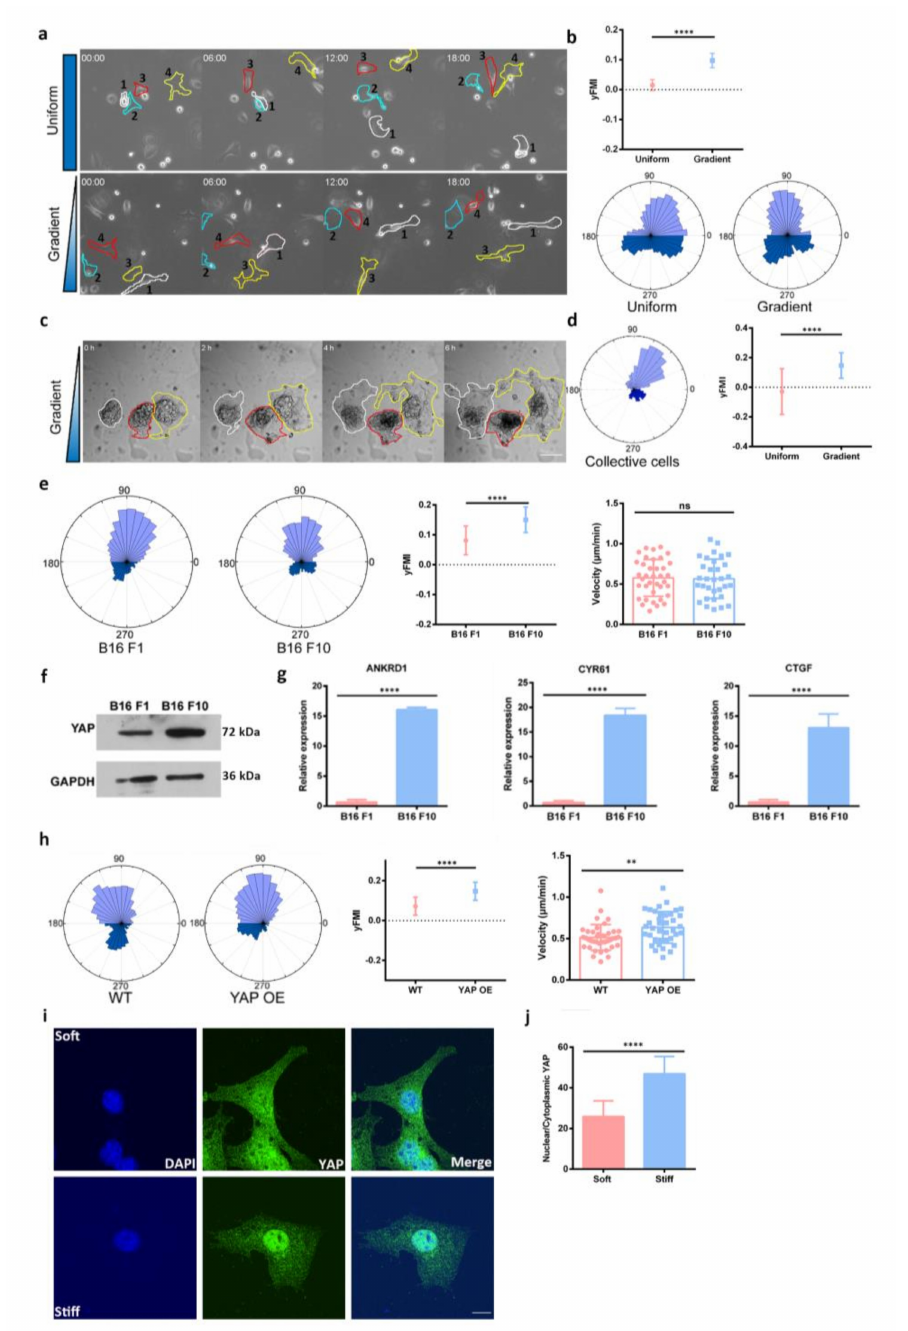
Figure 1. YAP promotes negative durotaxis of melanoma cells. ( a ) Representative time-lapse images showing the migration of single B16 F1 cells on the surface of polyacrylamide gels with uniform stiffness (top) and stiffness gradient (bottom), referring as random migration and durotaxis migration, Scale bar: 10 µ m. ( b ) Upper right: Y-axis forward migration index (yFMI) of B16 F1 cell migration on stiffness gradient polyacrylamide (PA) gels, error bar is SD, ****, p < 0.0001, by student’s t test. Lower right: Rose plot on the left shows B16 F1 migration on uniform stiffness PA gel, rose plot on the right shows B16 F1 migration on stiffness gradient PA gel n Uniform = 68, n Gradient = 64. ( c ) Representative time-lapse images of collective B16 F1 cells migration on the surface of gradient PA gel, the three spheroids were outlined by lines in different colors, Scale bar: 100 µ m. ( d )